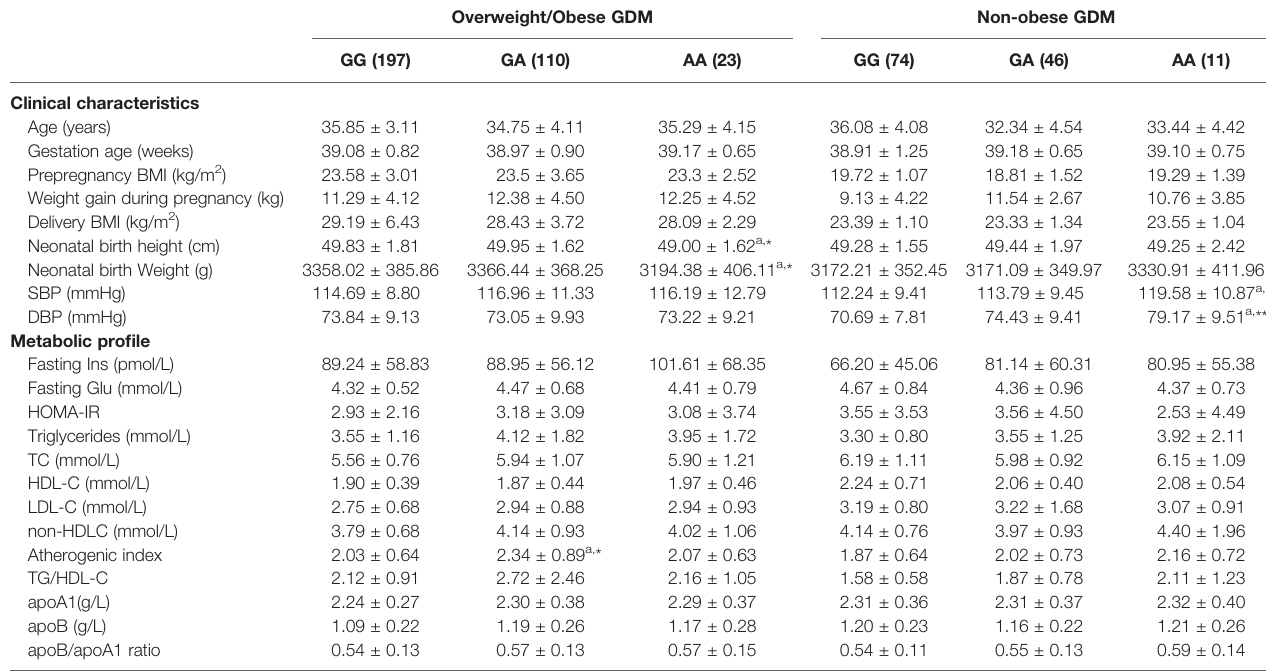
TABLE 4 | Clinical characteristics and metabolic pro fi le of GALNT2 rs4846914 genotypes in overweight/obese and non-obese GDM patients.